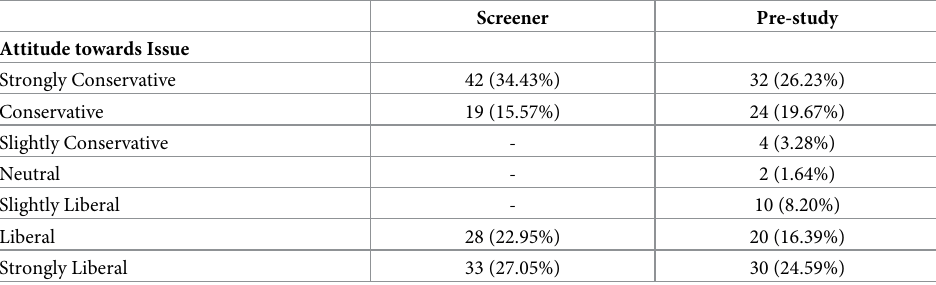
Table 2. Attitudinal distribution of participants.